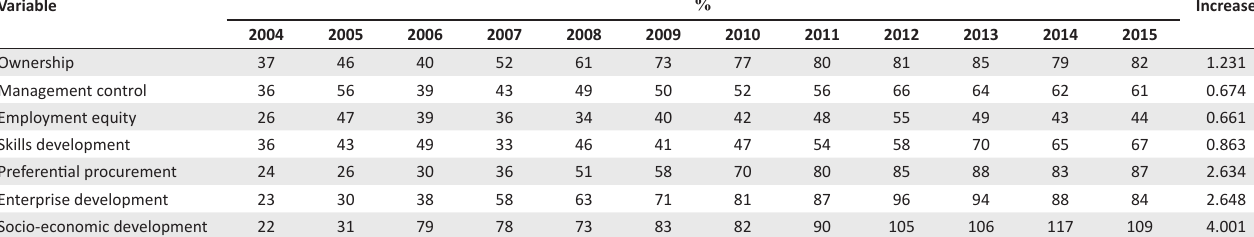
TABLE 8: Percentage change in the elements scores between 2004 and 2015. Variable %